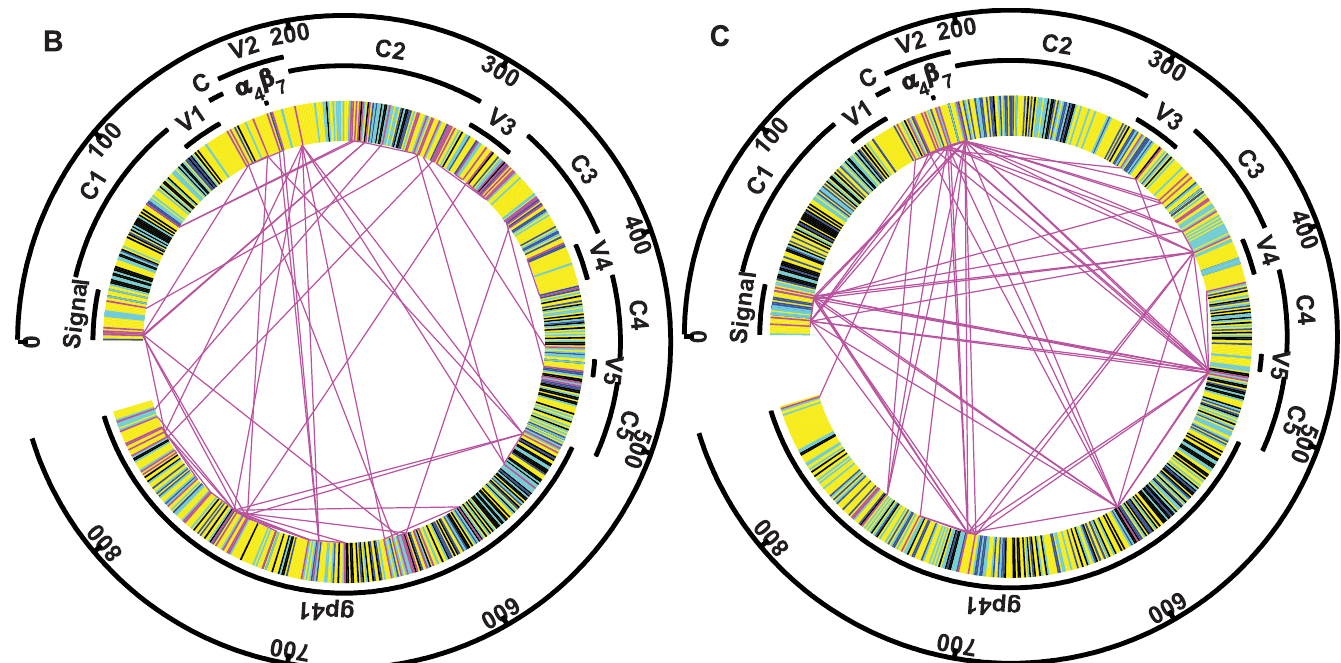
Fig 2. Conservedand covarying regions for subtypes B and C Env . Regionsare colouredas conservedacross both subtypes(black), conserved within each subtype (dark blue), conservedexcept for a maximum of 2 individualsin that subtype (light blue), and covarying(magenta). Those covarying pairs with at least 20% of the maximum covariancevalue for subtype C, and 12.5% for subtype B, are connectedwith magentalines. The different levels of covariancewere determined to includeapproximately the same numbers of covaryingpairs in each case: 78 for subtype B and 79 for subtype C. The signal, α 4 β 7 bindingsite, constant (C1-C6) and variable(V1-V5) regions within gp120, and the gp41 domain are mappedonto the Env